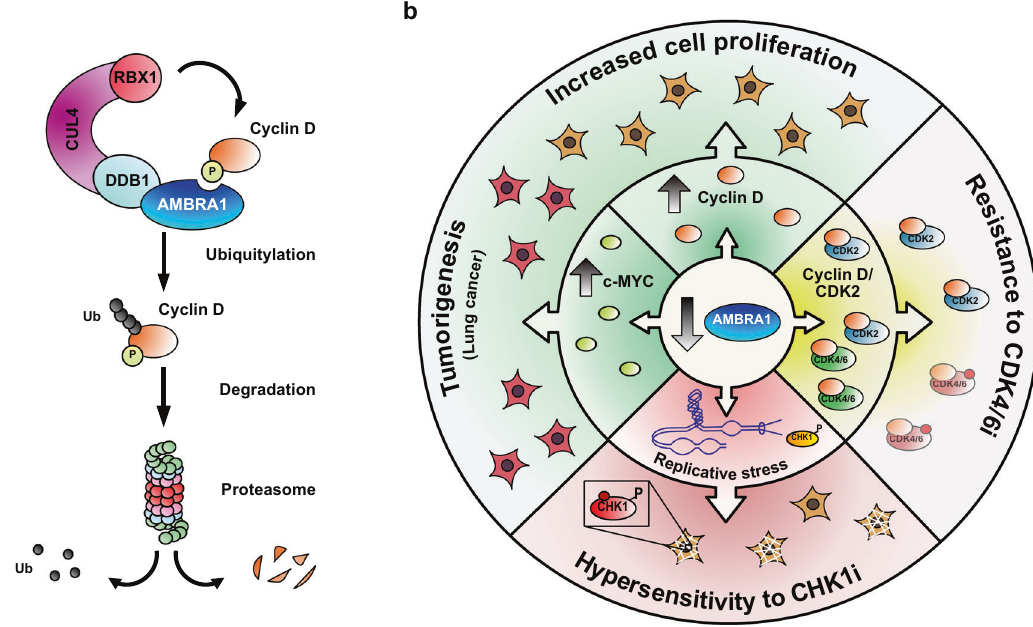
Fig. 1 Impact of AMBRA1 depletion on cell proliferation and targeted therapy. a The CRL4 AMBRA1 complex (E3 ligase complex including the proteins cullin4 (CUL4), RING box protein 1 (RBX1), damage-speci fi c DNA binding protein 1 (DDB1) associated to AMBRA1) directly ubiquitylates (Ub chain) the phosphorylated form of cyclin D and targets it for degradation through the proteasome. b The loss of AMBRA1 results in the stabilization of cyclin D and members of the MYC protein family, which leads to increased cell proliferation and promotes tumorigenesis, as observed for lung adenocarcinoma and lymphoma, by executing its canonical role by activating the cell cycle kinases CDK4 and CDK6. In cells with a reduced amount of AMBRA1, cyclin D associates in addition with CDK2, so that cancer cells develop treatment resistance to CDK4/6 inhibitors, since the cyclin D – CDK2 complex is not sensitive to these inhibitors. In addition, AMBRA1-depleted cells face replicative stress due to the increased proliferation rate, which results in the activation of the checkpoint kinase CHK1 and the increased sensitivity to CHK1